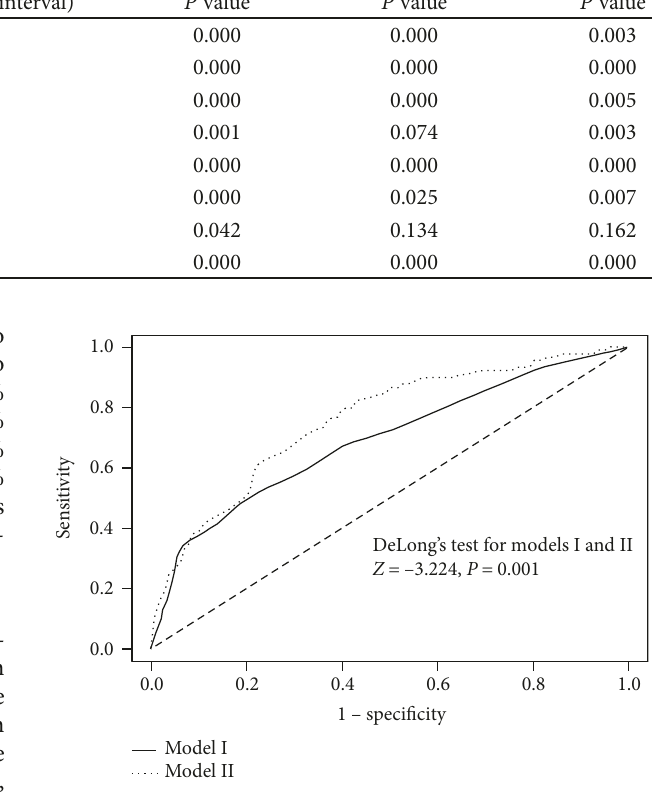
Figure 1: Areas under the curve between control and colorectal cancer individuals with borderline serum CEA levels (2 – 4 ng/mL). The prediction model is for discriminating between control and colorectal cancer individuals. Model I was designed only with the observed CEA level, whereas model II was designed with the observed CEA level and the adjusted CEA